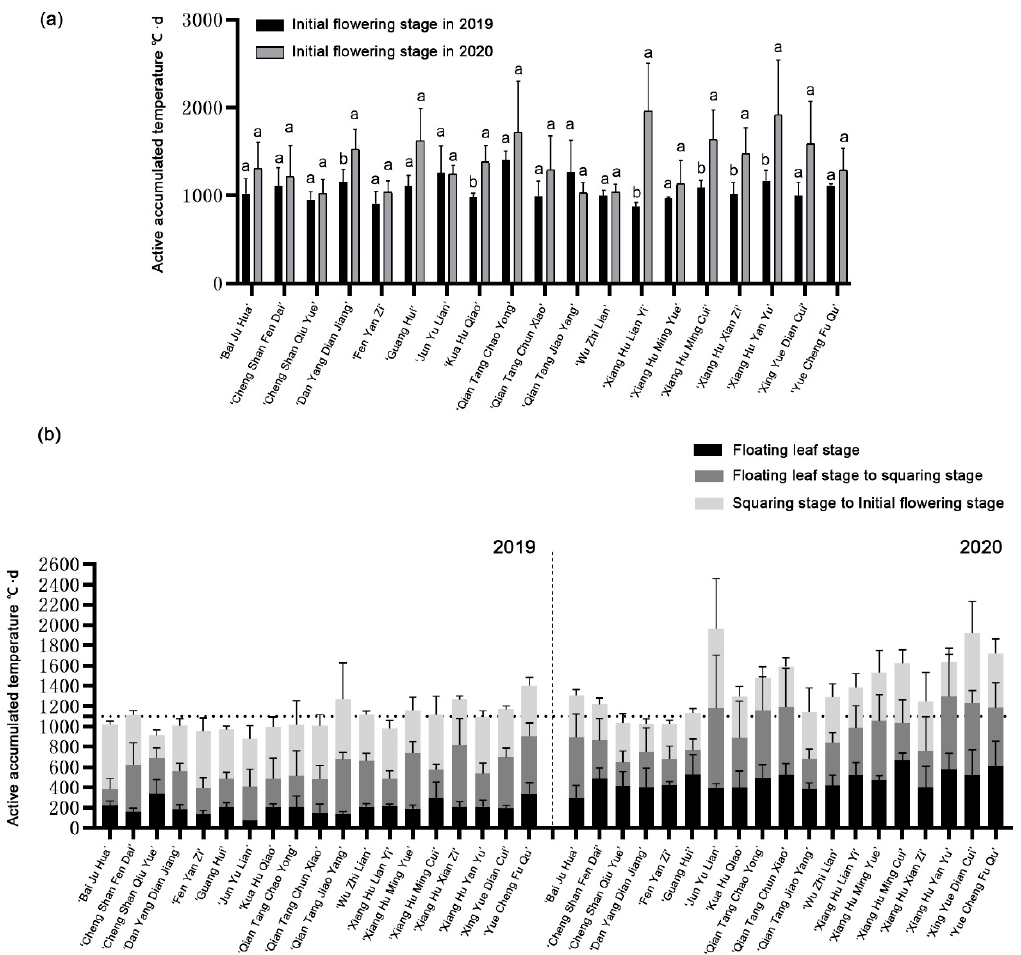
Figure 3. Comparison of accumulated temperature required for each growth period of 19 cultivars in 2019 and 2020. ( a ) Accumulated temperature required for initial flowering stage in 2019 and 2020. ( b ) Accumulated temperature required for each growth period in 2019 and 2020. Different lower case letters mean significant difference at p = 0.05.2.4. Flowering Identification of Three Typical Cul- tivars.